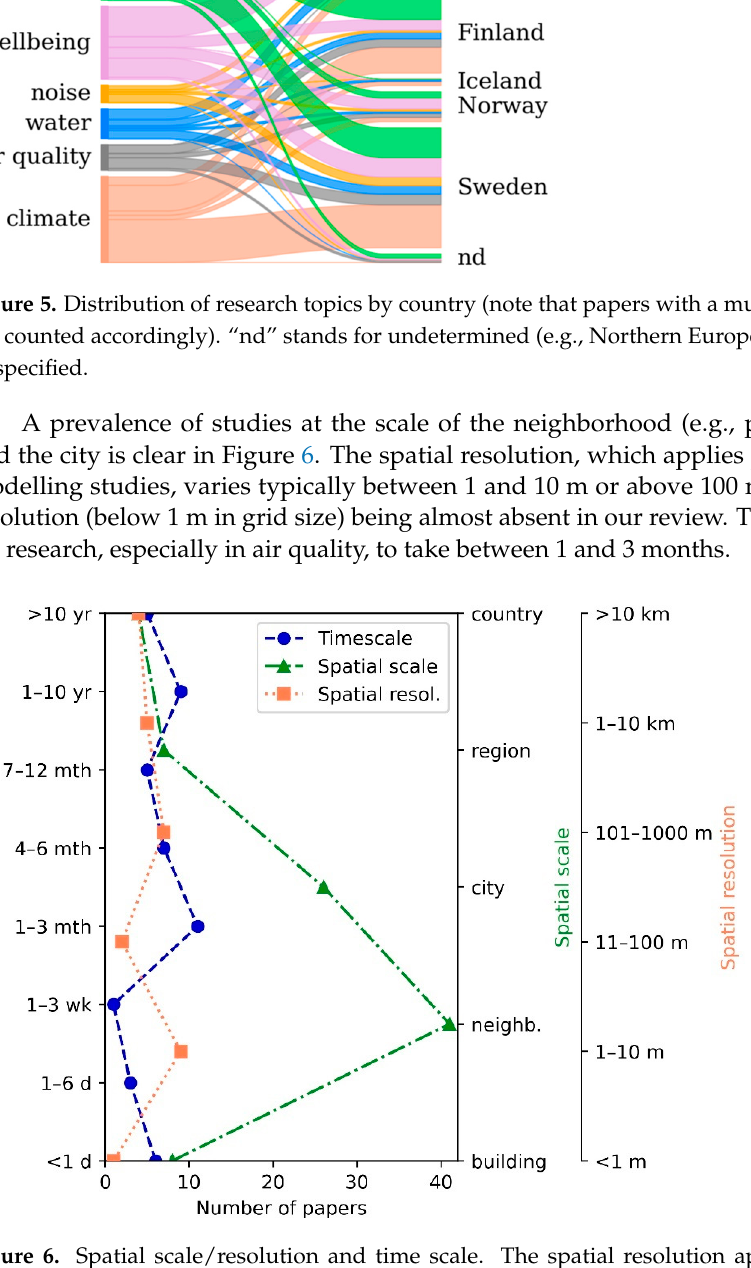
Figure 6. Spatial scale/resolution and time scale. The spatial resolution applies to modelling studies or spatial analyses (e.g., GIS works using raster data), where information about grid cell size is available. The time scale indicates the duration of the research (e.g., the period covered by a monitoring campaign or a model study). (d: day, wk: week, mth: month, yr: year, neighb.: